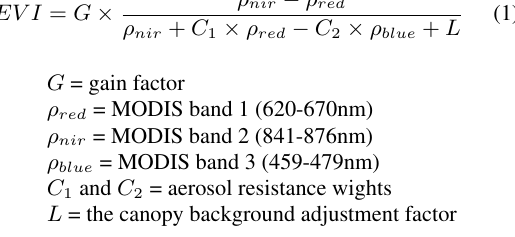
Figure 1: Corn yield in McLean, Illinois